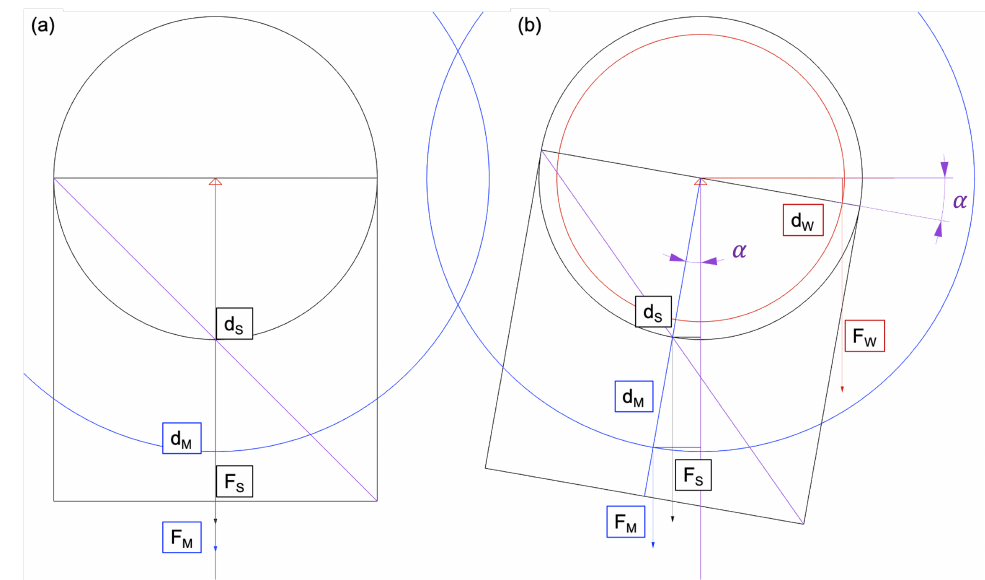
Figure 3. Schematic visualisation of the acting forces F and distances d from the pivot point for the swing, additional model and masses: ( a ) empty swing, which is in balance represented by an angle α = 0 ◦ ( b ) exemplary mass added so that α = 10 ◦